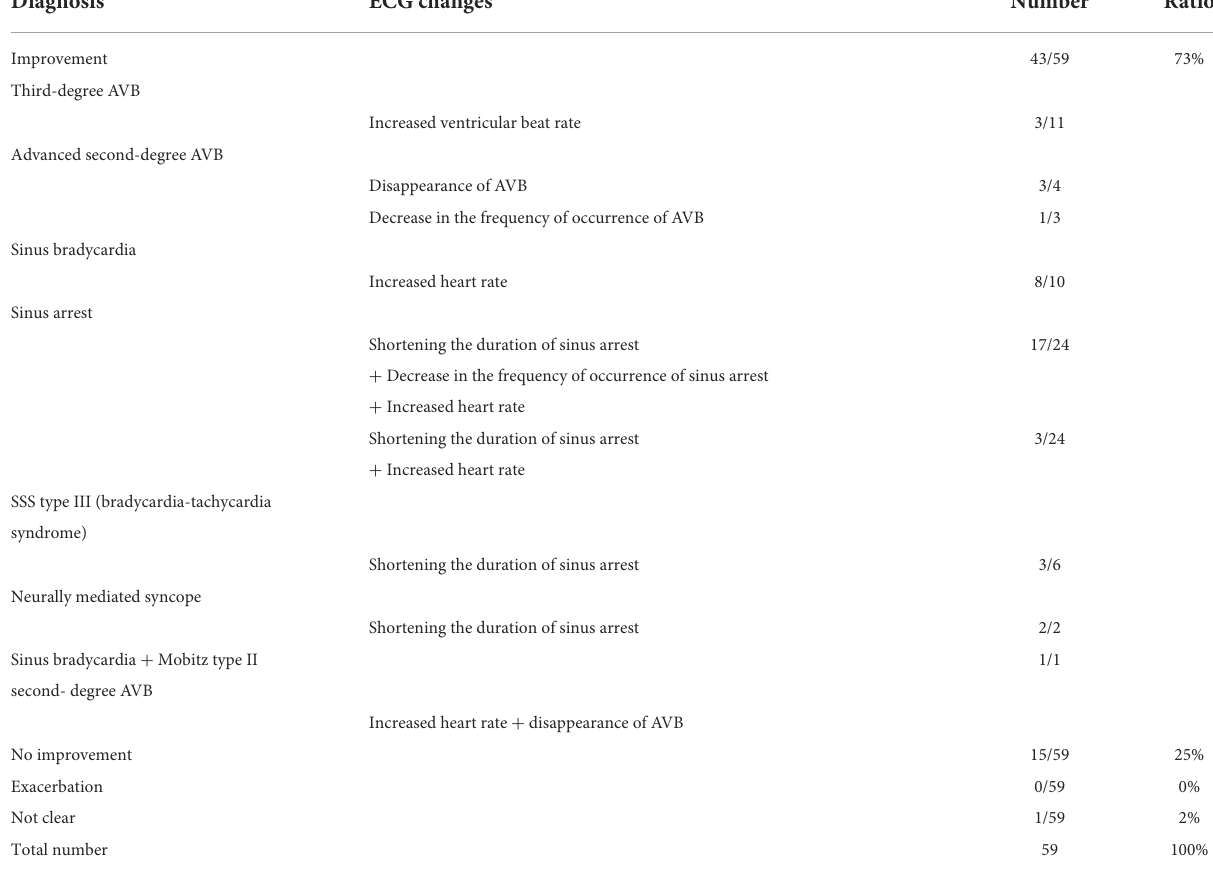
TABLE 5 Changes in ECG findings after administration of